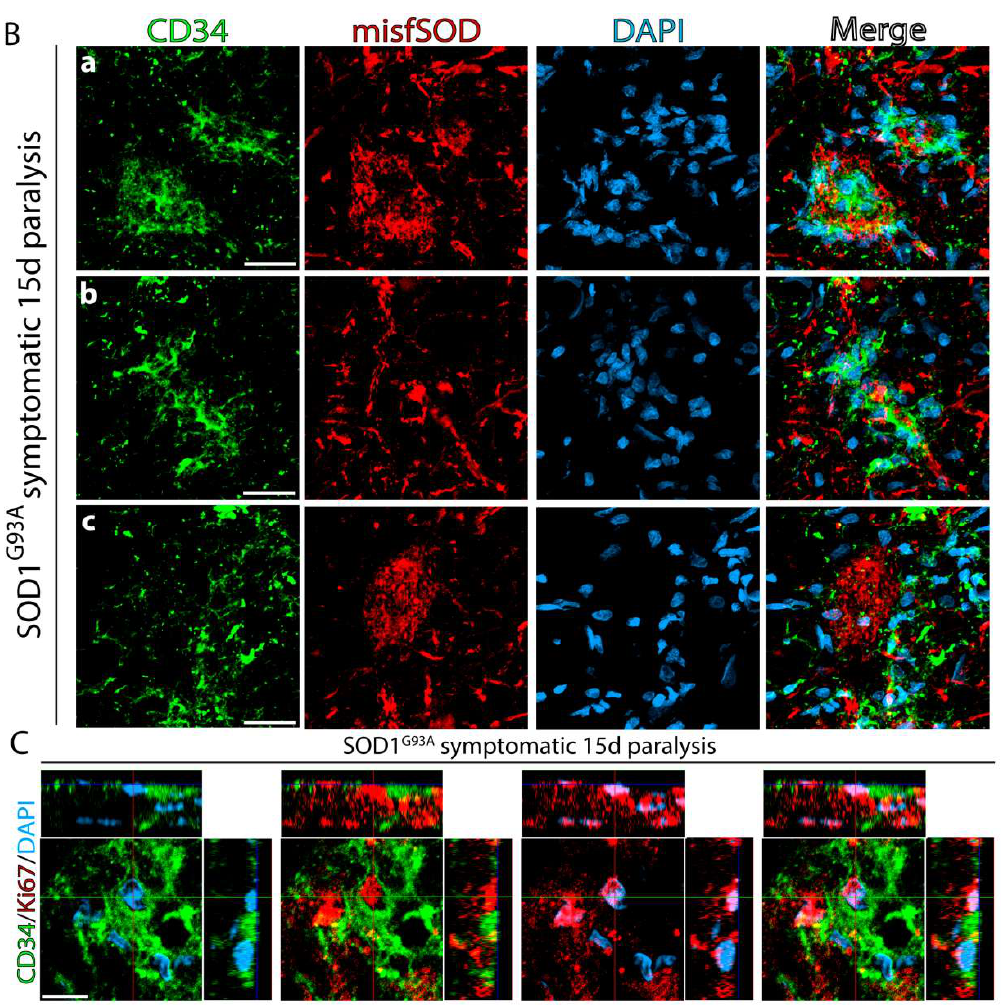
Figure 4. CD34 + cells accumulate adjacent to motor neurons expressing misfolded SOD1. ( A ) Confocal tile reconstruction of the ventral horn showing CD34 + cell clusters adjacent to motor neurons expressing misfolded SOD1. CD34 + cells completely surround and attach to damaged motor neurons expressing misfolded forms of SOD1 and form compact clusters of cells, both around motor neuron somas ( a ) and processes ( b ). Other motor neurons accumulating misfolded SOD1 have less CD34 + cells invading them ( c ). ( B ) Higher magnification analysis showing the clustering of CD34 + cells around motor neuron somas and processes. ( C ) Orthogonal view of the staining of proliferating CD34 + cell clusters expressing nuclear Ki67. Arrows indicate Ki67 + nuclei in a CD34 + cell cluster. Scale bars: 25 µ m ( A,B ) and 10 µ m ( C ).